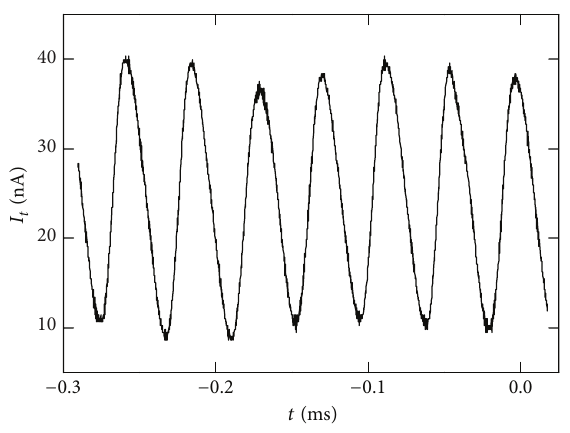
Figure 5: A waveform of the probe current oscillations measured when oscillating loop is connected into the AFM probe-YSZ/Si film- bias source circuit (Figure